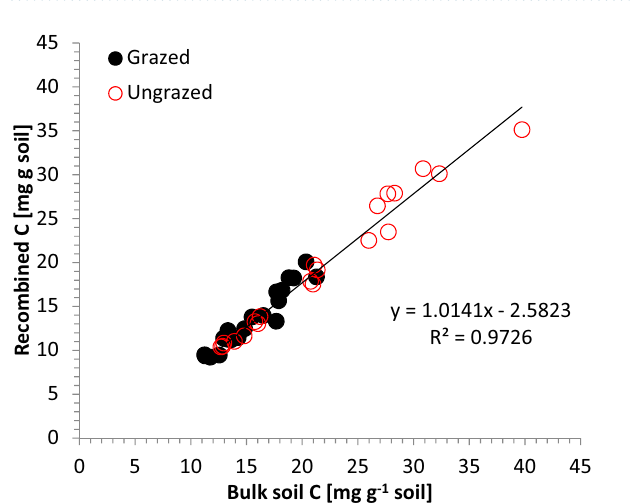
Figure 1. Partitioning of organic carbon between different physical fractions in grazed and ungrazed soil profiles. The contributions of the four physical fractions in each plot and depth increment sum up to the total organic carbon content of the respective layer. Differences to the bulk soil organic carbon content are losses due to physical fractionation (compare Table 1). Each box gives the mean of four fractionated samples (two profiles per plot × two blocks per sampling depth).